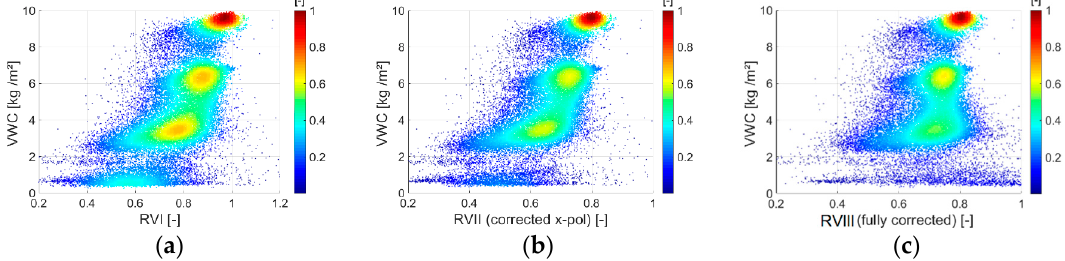
Figure 12. Correlation for the combined study areas between: ( a ) RVI [-]; ( b ) x-pol corrected RVII [-]; ( c ) fully corrected RVIII [-] and MODIS-based volumetric vegetation water content (VWC) [kg/m 2 ] [18].